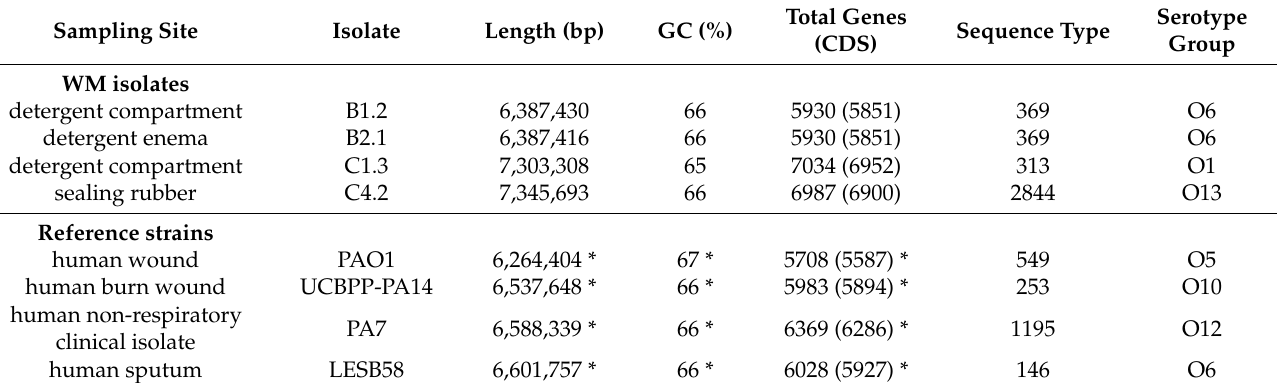
Table 2. Table of P. aeruginosa WM isolates and P. aeruginosa reference strains. Sequence types were determined using the MLST, by scanning the isolates/reference strains against PubMLST typing schemes. In silico serotyping was performed using PAst, based on BLAST analysis of the O-specific antigen (OSA) gene cluster. Information taken from the Pseudomonas Genome Database is marked with a star (*)